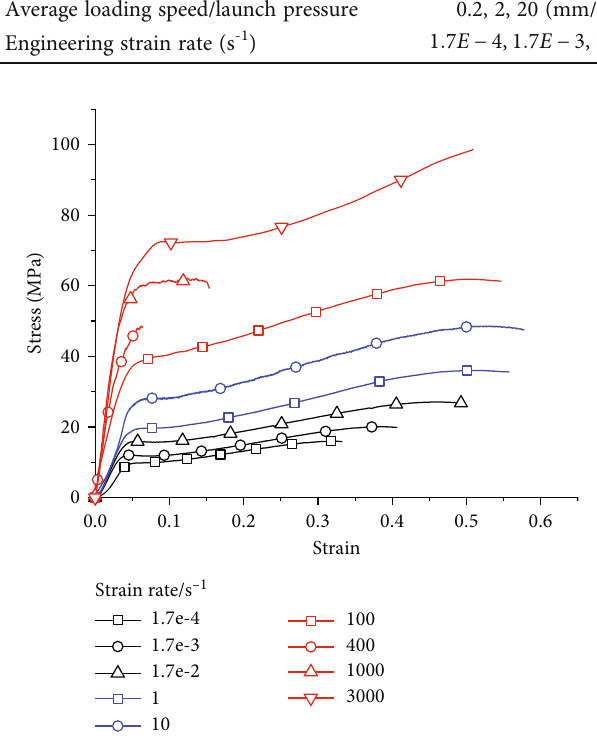
Figure 3: True stress – strain